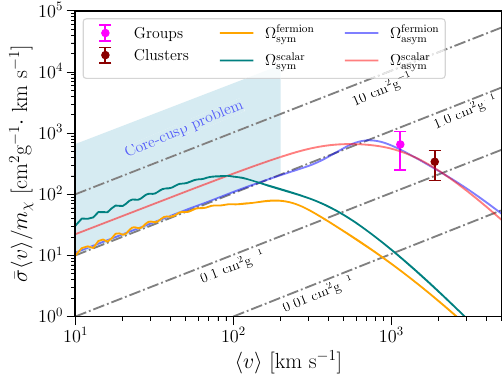
Fig. 4 Red and blue (green and orange) lines correspond to average DM viscosity self-interaction cross sections ¯ σ for scalar and fermionic asymmetric (symmetric) DM. Here, m Z (cid:3) = 10 MeV with DM mass m χ = 4 ( 15 ) GeV for asymmetric (symmetric) DM. The green and orange lines have (cid:17) asym h 2 (cid:13) (cid:17) sym h 2 (cid:6) 0 . 12, the red and blue lines have (cid:17) asym h 2 (cid:6) 100 (cid:17) sym h 2 (cid:6) 0 . 12. Diagonal dot-dashed lines are contours of constant ¯ σ/ m χ ; data points and core–cusp problem region from Refs. [48,51]. The small wiggles at small (cid:9) v (cid:10) are an unphysical artifact of